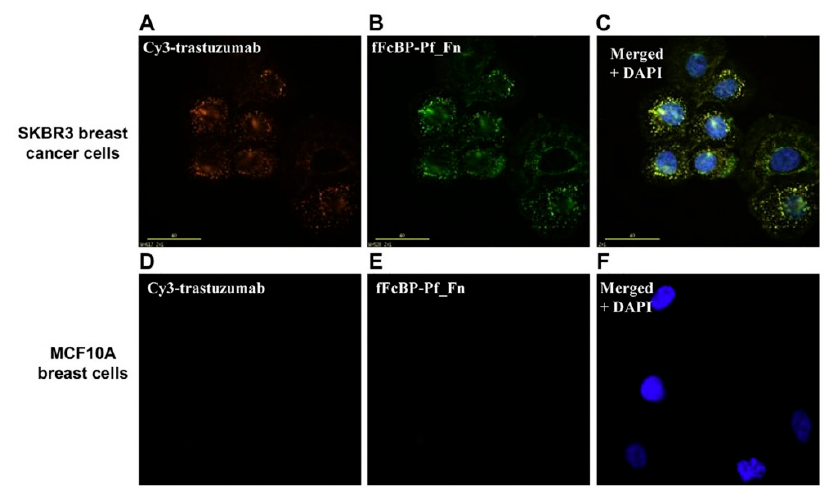
Figure 7. Fluorescent microscopic images of SKBR3 breast cancer cells ( A – C ) and MCF10A breast cells ( D – F ) treated with Cy3-trastuzumab/fFcBP-Pf_Fn complexes. Trastuzumab and FcBP-Pf_Fn were labeled with Cy3 (Cy3-trastuzumab) and fluorescein (fFcBP-Pf_Fn), respectively. Cy3-trastuzumab was simply mixed with fFcBP-Pf_Fn to form Cy3-trastuzumab/fFcBP-Pf_Fn complexes and subsequently incubated with SKBR3 breast cancer cells and MCF10A breast cells in the presence of excess amounts of rabbit serum. Cy3-trastuzumab and fFcBP-Pf_Fn are visualized as orange and green, respectively, by fluorescence microscopy. (For interpretation of the references to color in this figure legend, the reader is referred to the web version of this article.) Adapted from [71], with permission from © 2012 Elsevier.